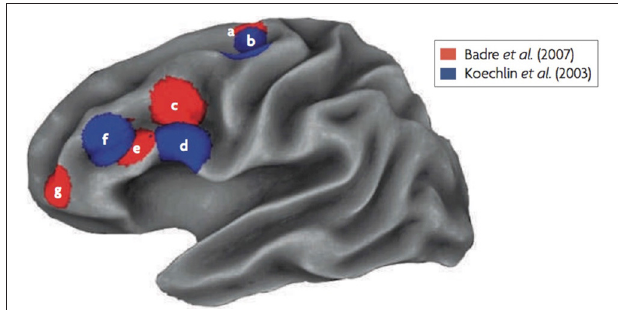
FIGURE 1 | fMRI results of the Koechlin et al. (2003) and Badre and D’Esposito (2007) experiments. Regions labeled as “a” and “b” are the lowest abstraction levels (sensory and response tasks), labels “c” and “d” are second lowest in abstraction (context and feature tasks), labels “e” and “f” are the third highest in abstraction (episodic and dimension tasks) and label “g,” that was only used by Badre and D’Esposito (2007), is the highest in abstraction (context